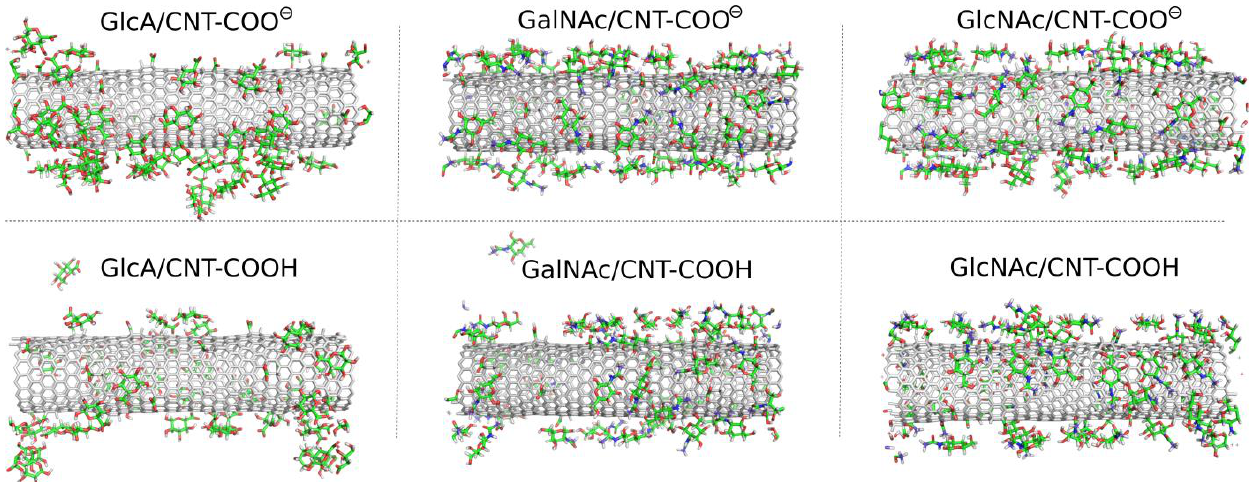
Figure 2. MD simulation snapshots taken at the last simulation frames, i.e., after 600 ns for the fCNT systems with monosaccharides. The temperature and pressure were 310 K and 1 bar, respectively.